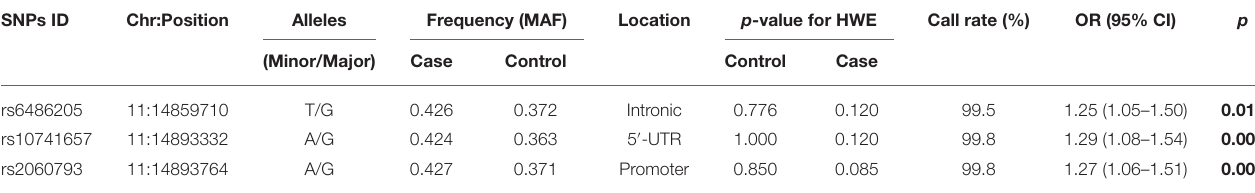
TABLE 2 | Information about CYP2R1 SNPs and association with CHD risk in allele